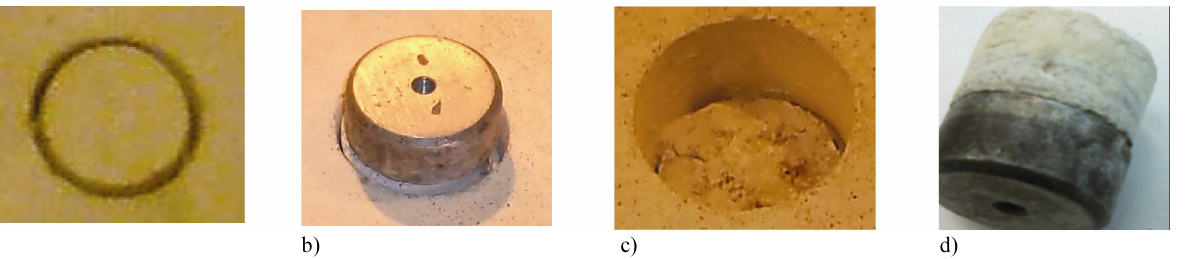
Fig. 1. Damage to floor surface caused by pulling off piece (50 mm in diameter) of it from base: a) incision of concrete piece to be pulled off; b) sticking on special metal disk; c) top layer after test; d) pulled off piece of concrete